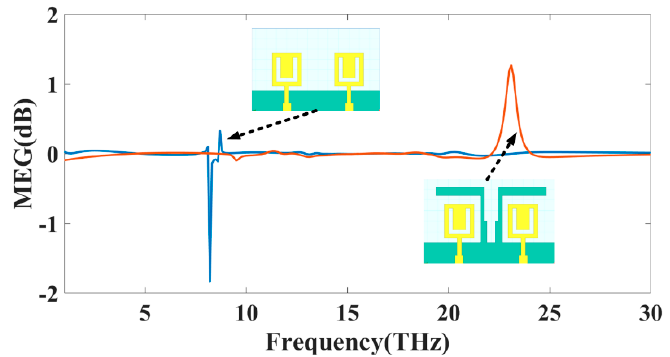
Figure 5. The MEG (dB) simulated value for MIMO structure Design 3 and 4.